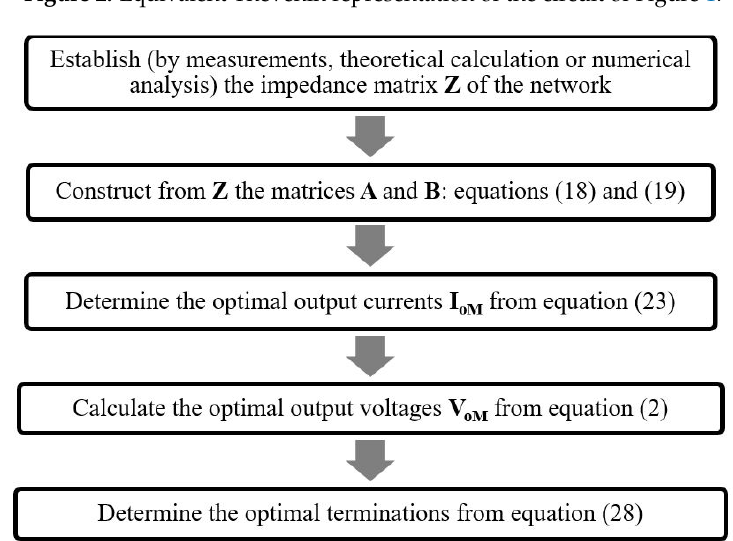
Figure 3. Block diagram of the proposed approach to determine the optimal terminations for efficiency maximization of a SIMO Resonant Inductive WPT